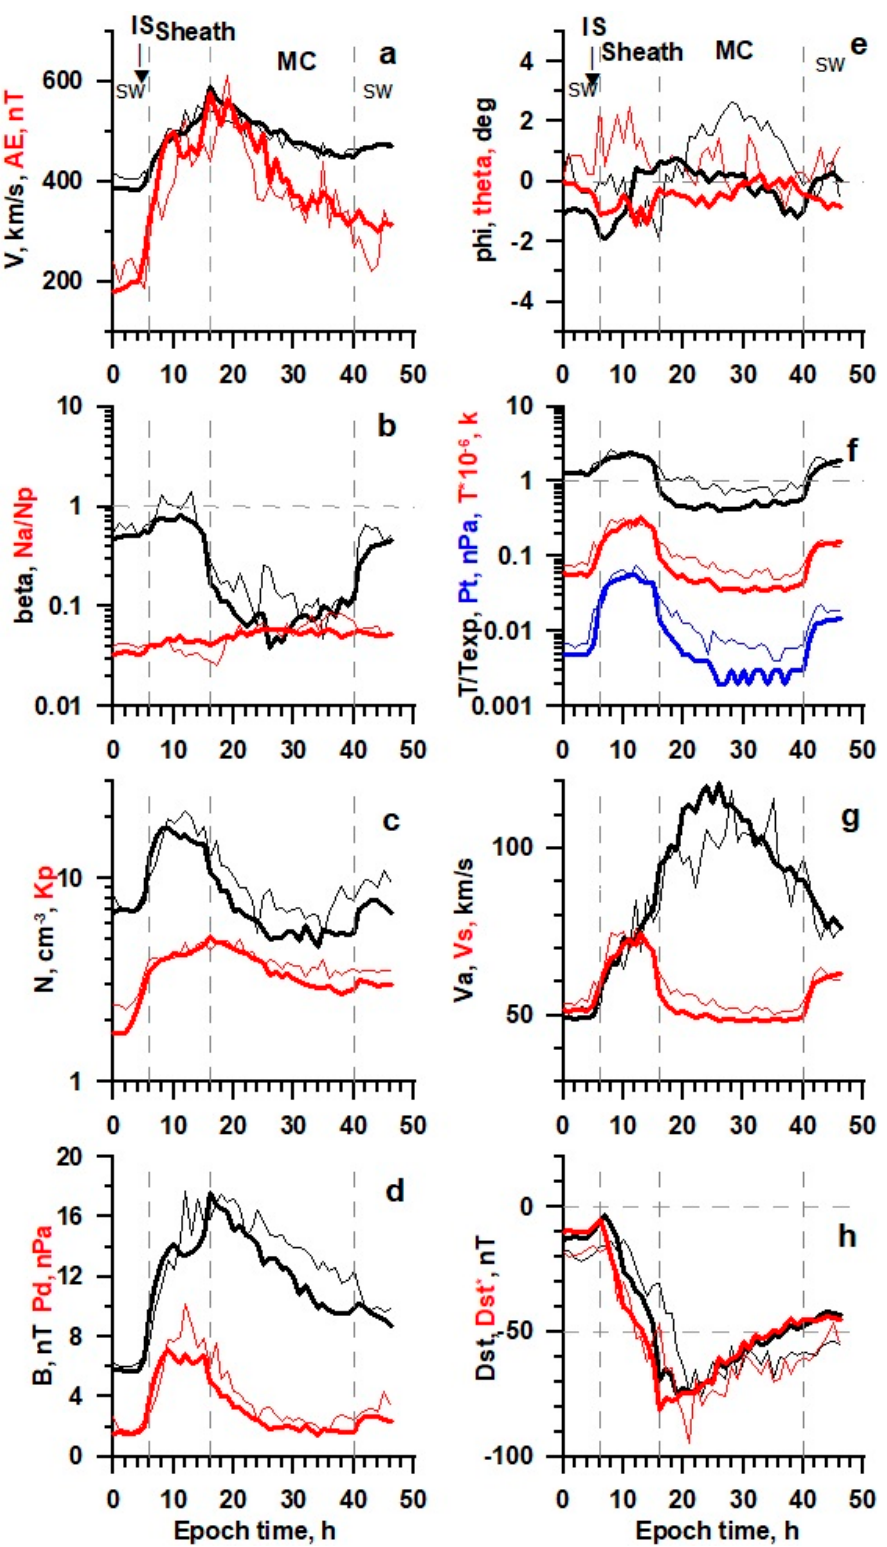
Figure 8. The temporal profile of solar wind and IMF parameters (see legend in the text) for IS/Sheath/Ejecta obtained by the double superposed epoch analysis for 32 events in 21–22 SCs (thin lines) and 123 events in 23–24 SCs (thick lines).